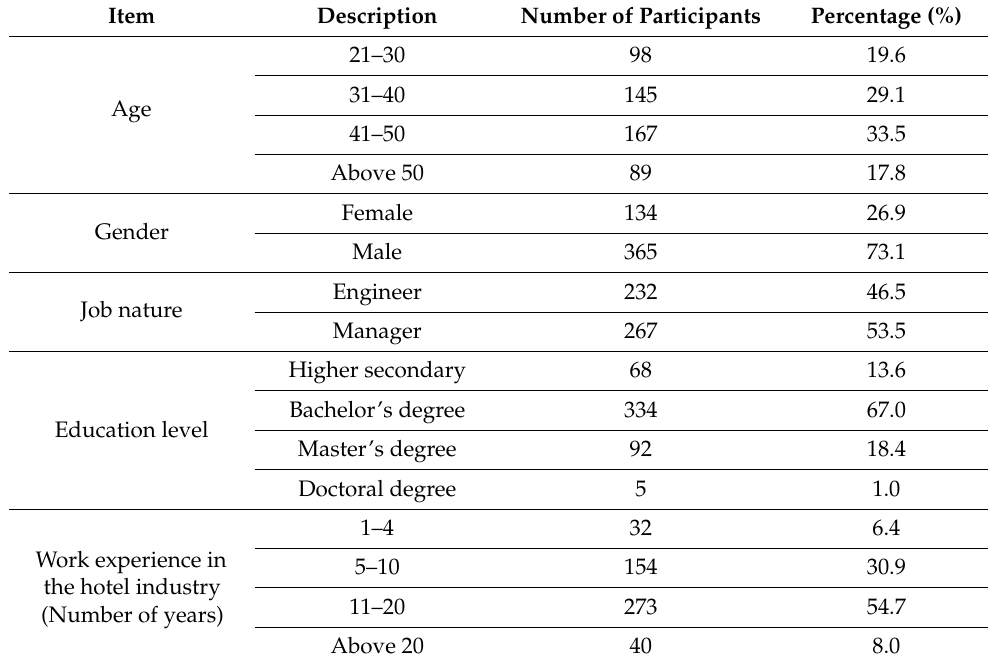
Table 2. Demographic information of participants ( n =